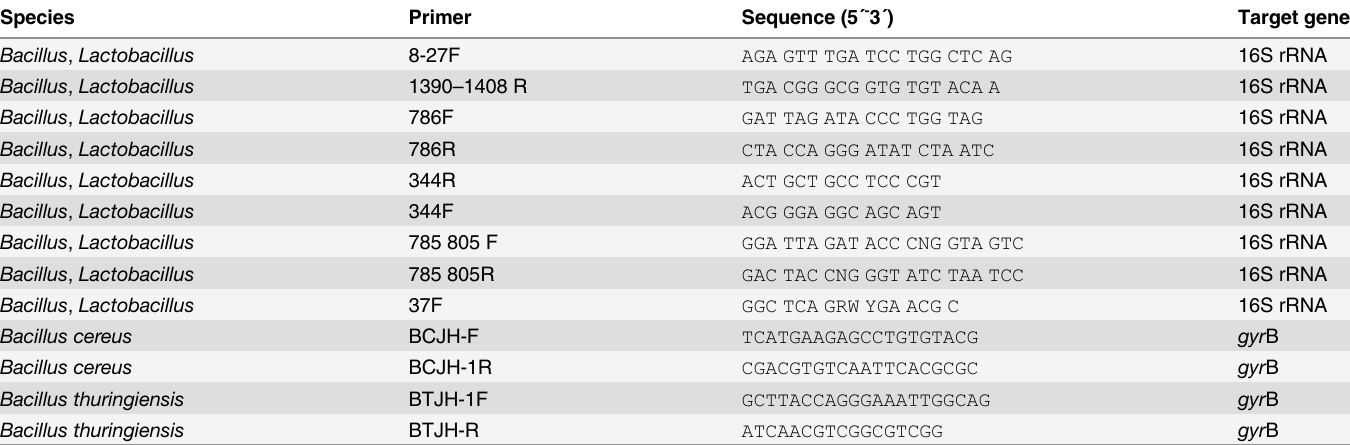
Table 3. Oligonucleotide primers used for 16S rRNA analysis and detection of the gyr B